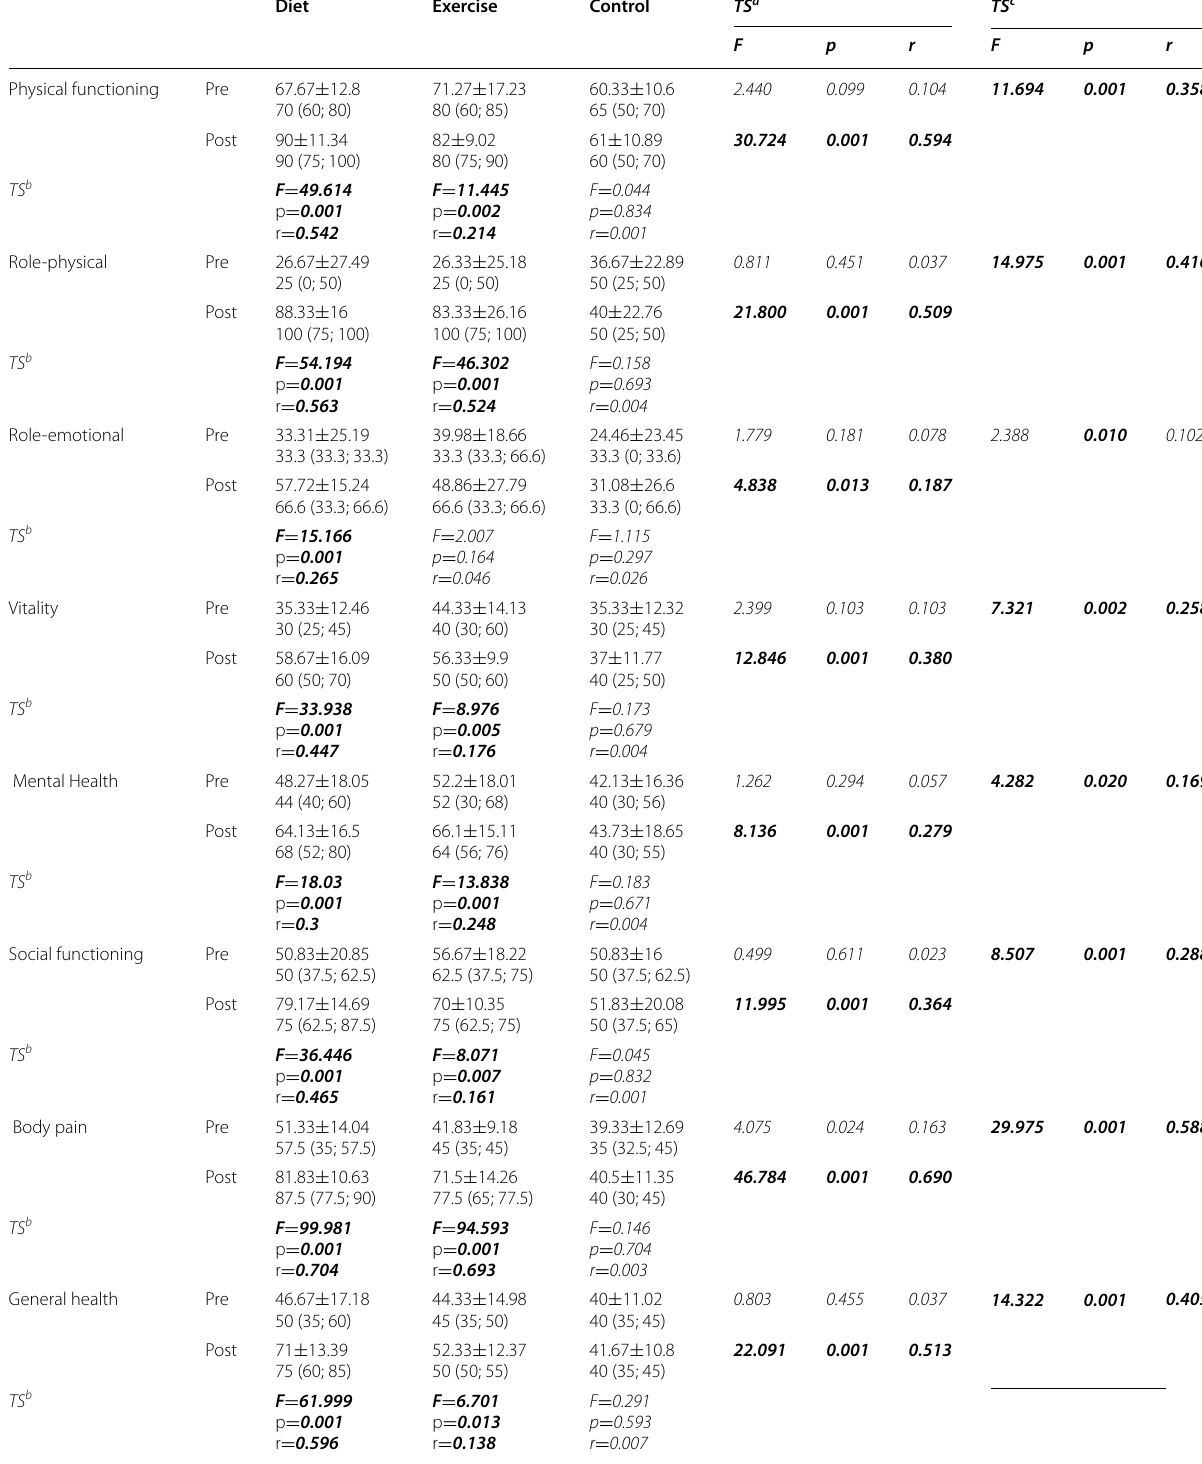
Table 3 SF-36 scores of